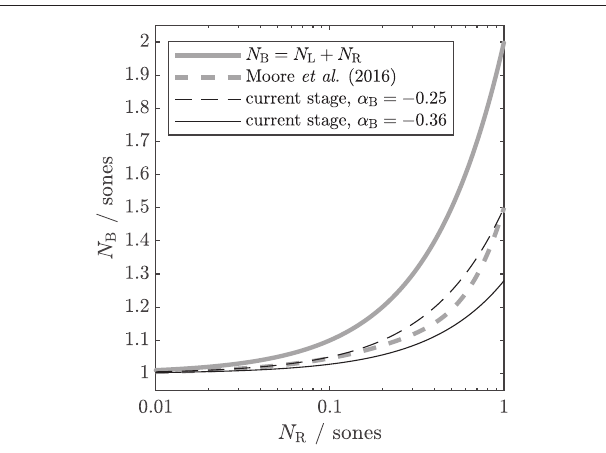
FIGURE 2 | Different theoretical assumptions of binaural summation, depicted as input-output functions. The output is the binaural loudness in sones N B . The input is the monaural loudness for the right ear N R , while the monaural loudness for the left ear N L is kept constant at 1 sone. In the suggested binaural stage, the individual amount of binaural summation can be controlled via a parameter α B . Gray solid line: the classical assumption that binaural loudness is the summed monaural loudness in sones. Gray dashed line: binaural stage of the loudness model of Moore et al. (2016). Black lines: simplified version ( β B = 0, N L and N R as input) of the current binaural stage with α B = − 0.25 (dashed; comparable to Moore et al., 2016) and α B = − 0.36 (solid; obtained from the first experiment of this